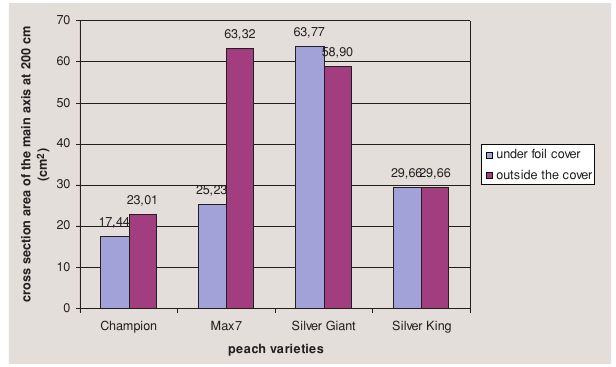
Figure 3. The cross section area of the main axis of 8 year old peach trees at